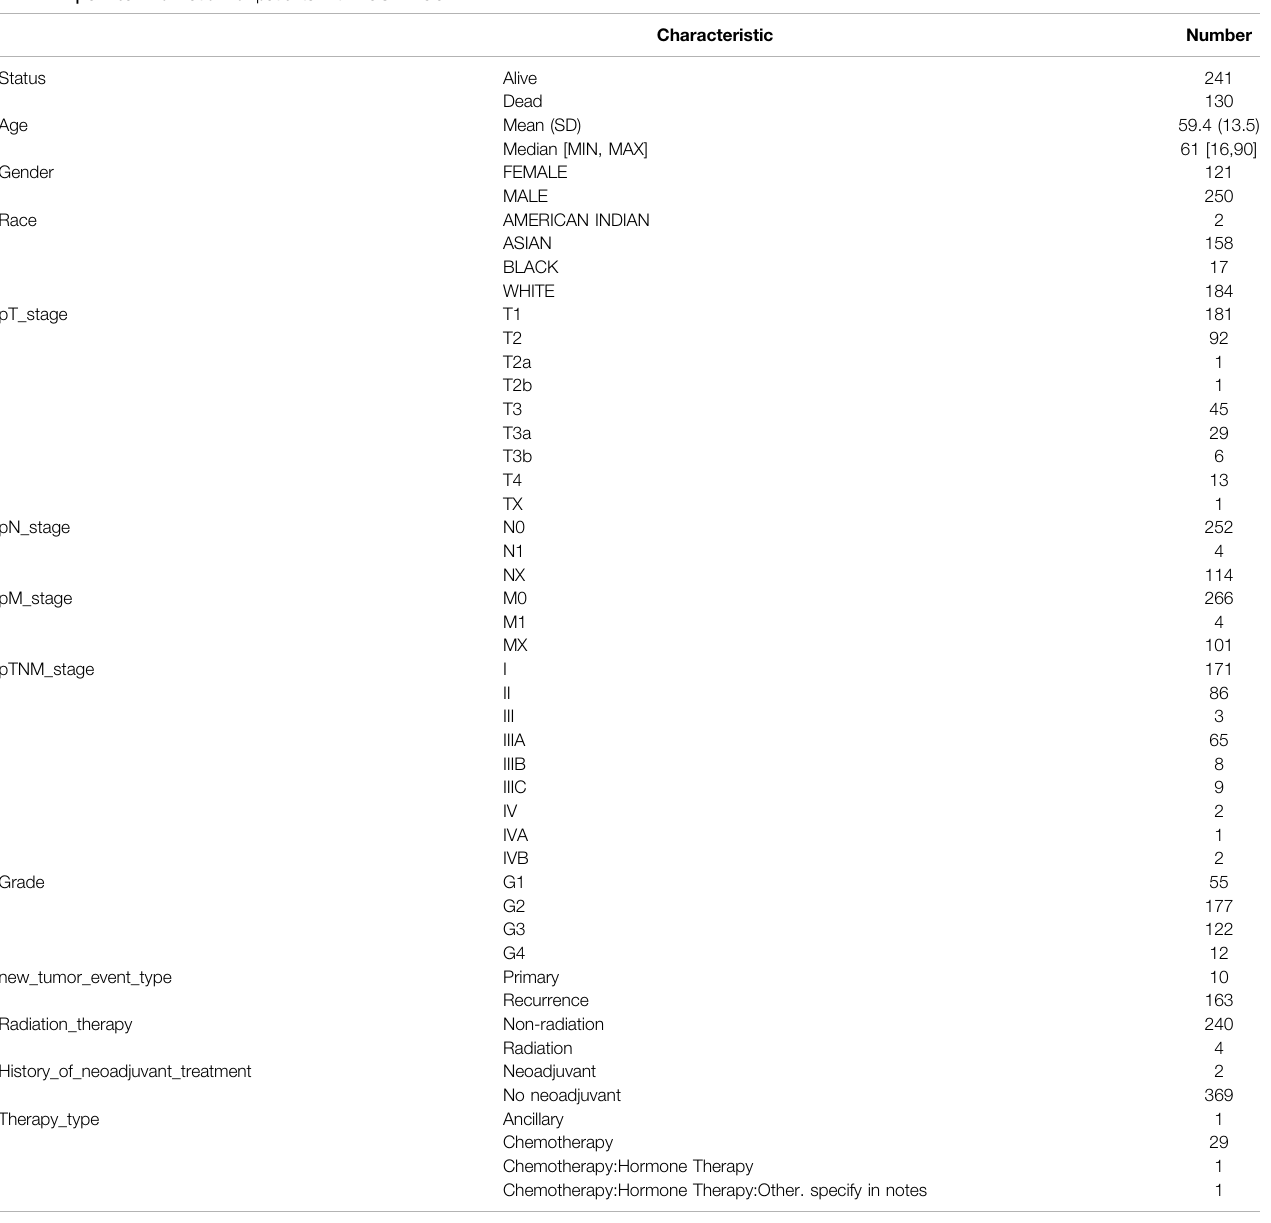
TABLE 1 | Clinical information for patients with